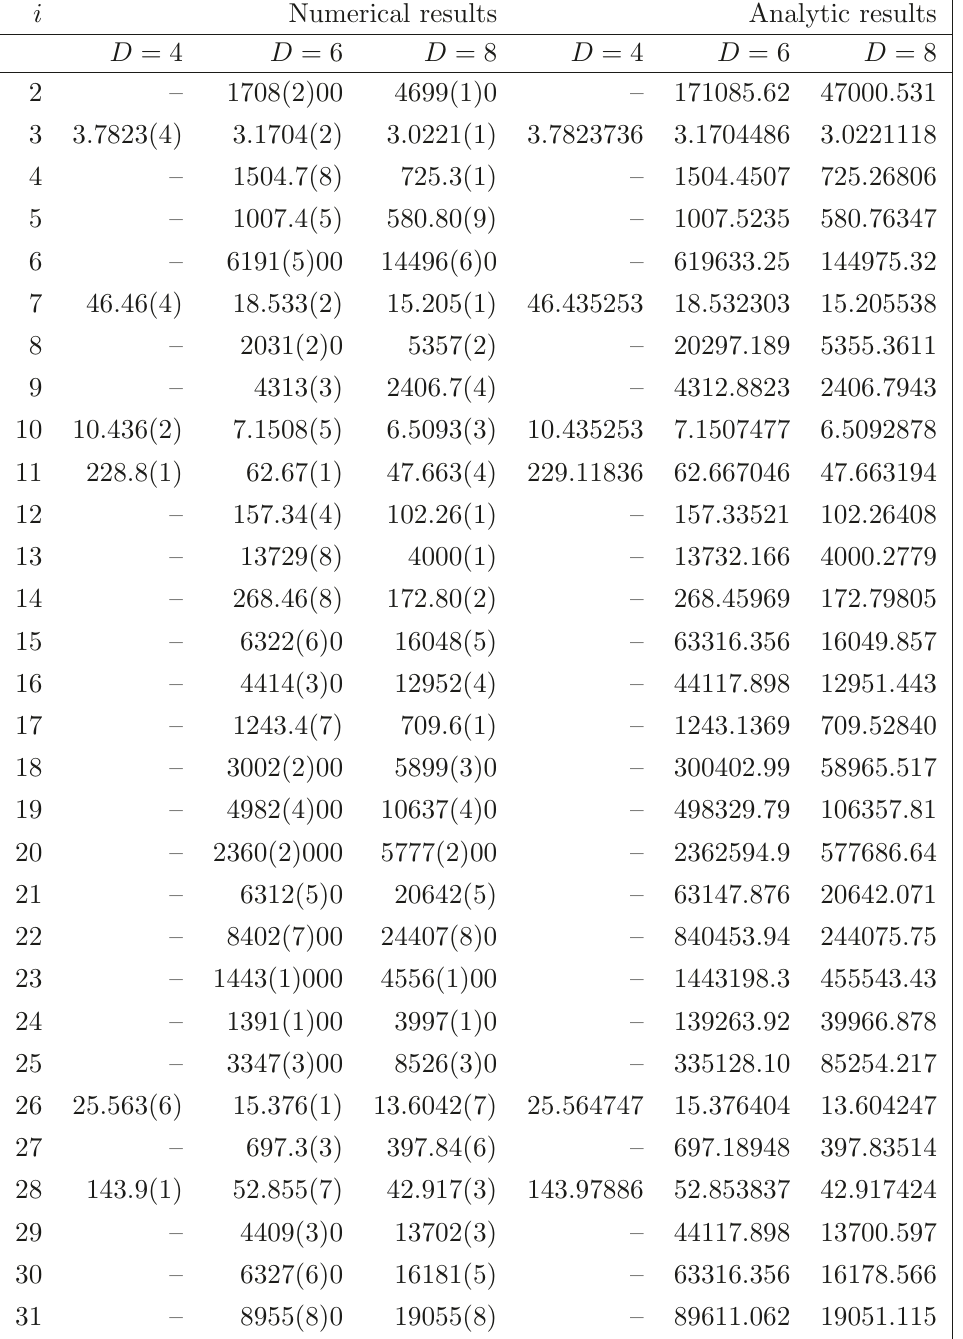
Table 2 . Numerical results for the ratio F i /F 1 with the corresponding uncertainties (standard deviations) indicated in the parenthesis. Missing entries correspond to divergent